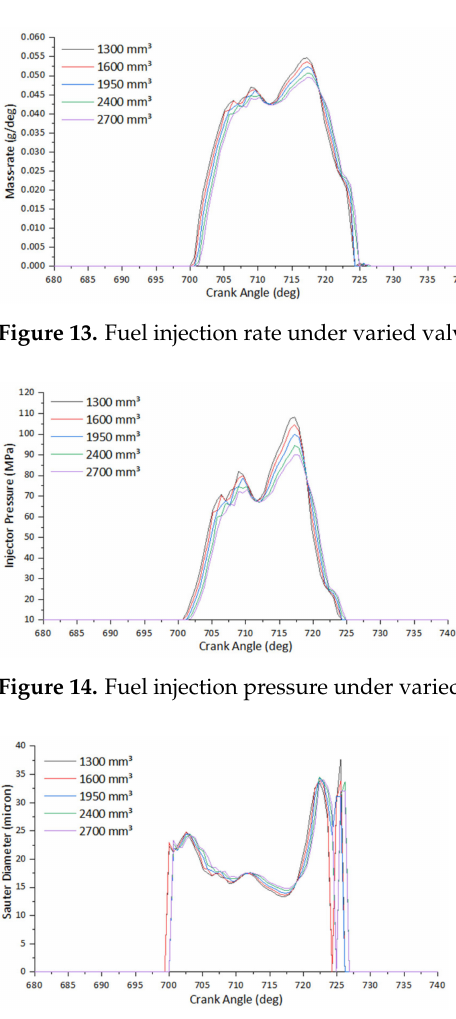
Figure 12. Cumulative fuel injection mass per cycle under varied valve volumes.